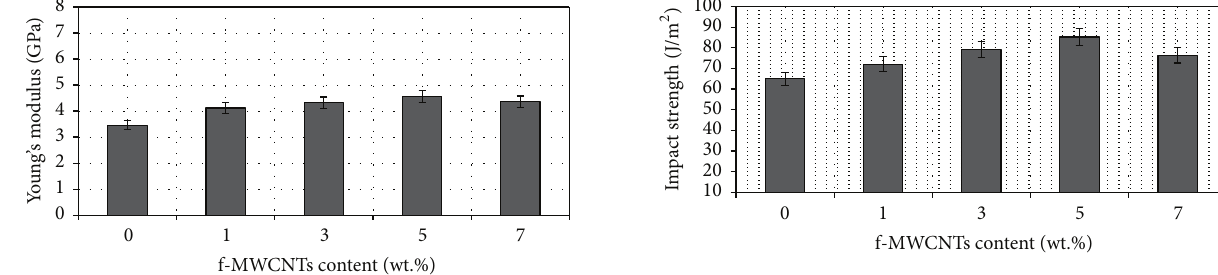
Figure 6: Effect of f-MWCNTs on Young’s modulus of nanocom- posites.